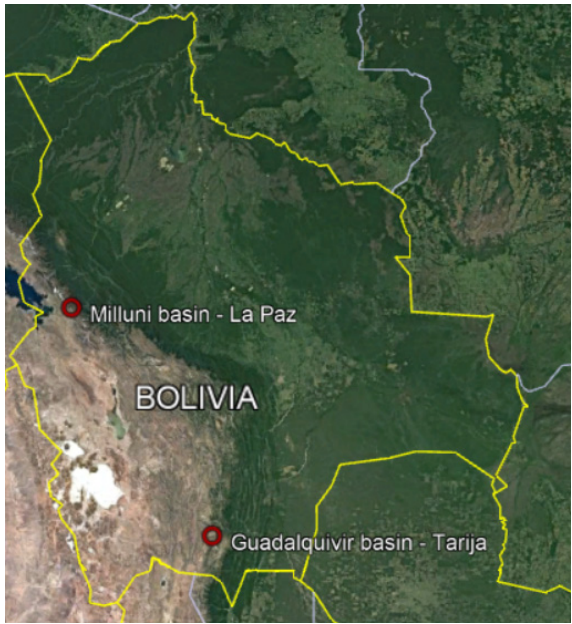
Figure 1. Location of the Guadalquivir and Milluni